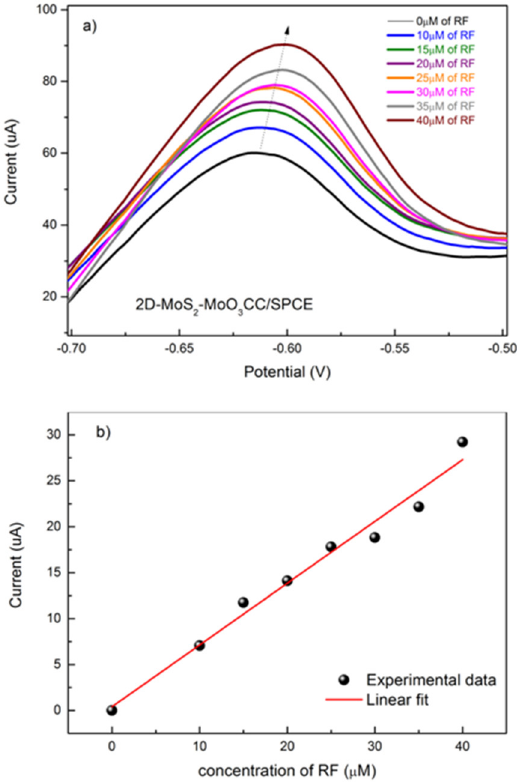
Figure 8. ( a ) Linear sweep voltammetry (LSV) of 2D-MoS 2 -MoO3CC/SPCE, performed in 1 M PBS electrolyte and in the presence of different concentrations of RF. ( b ) Calibration curve for the determination of RF.